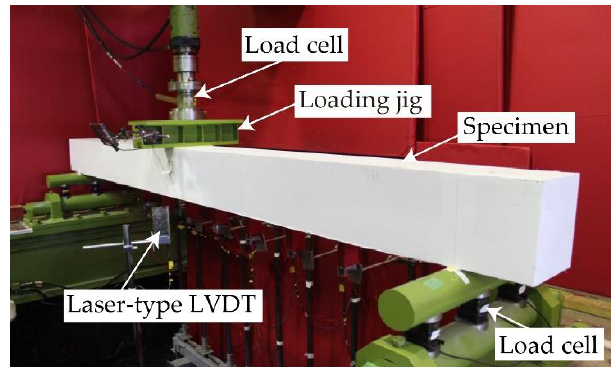
Figure 4. View of the test setup for static loading.